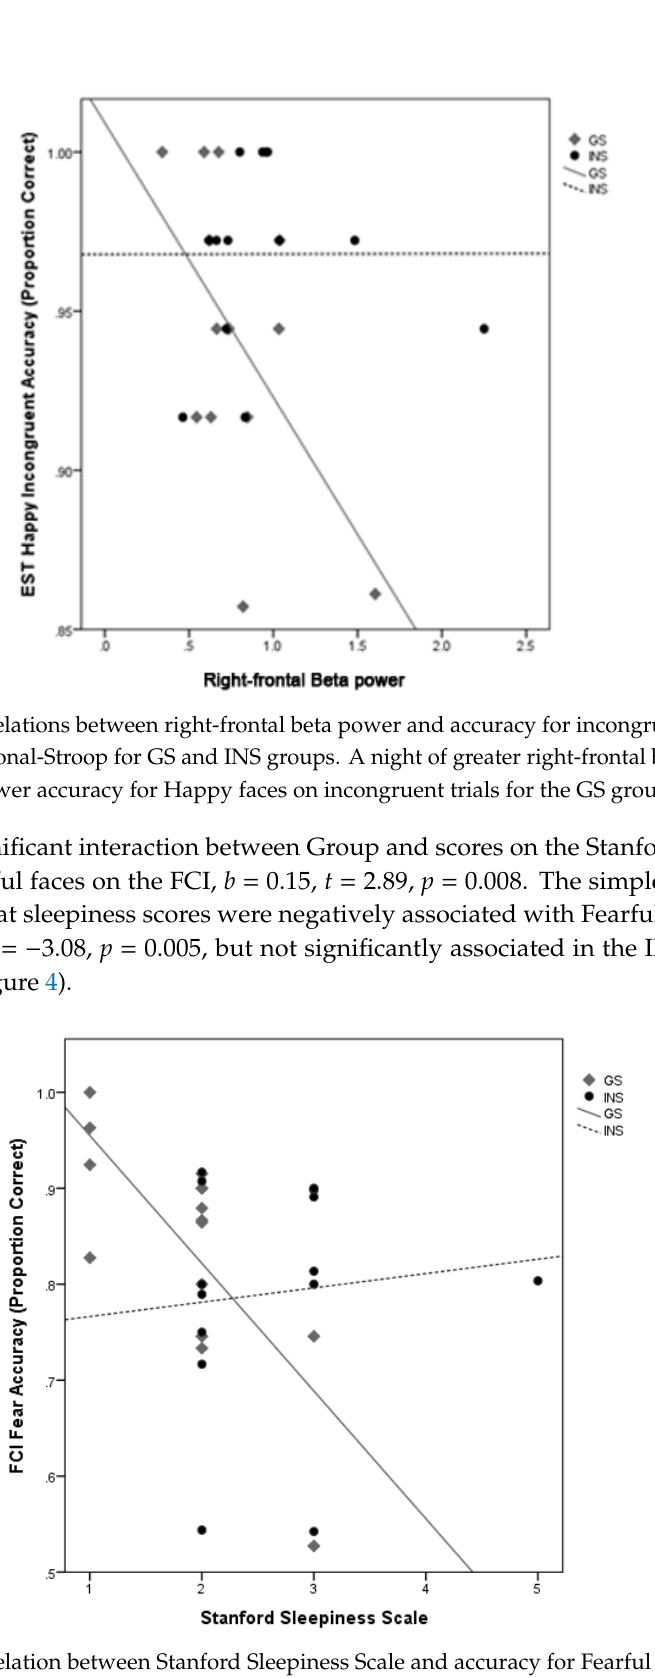
Figure 4. The correlation between Stanford Sleepiness Scale and accuracy for Fearful faces on the FCI for GS and INS groups. Sleepiness levels were negatively associated with Fearful accuracy for GS but not the INS